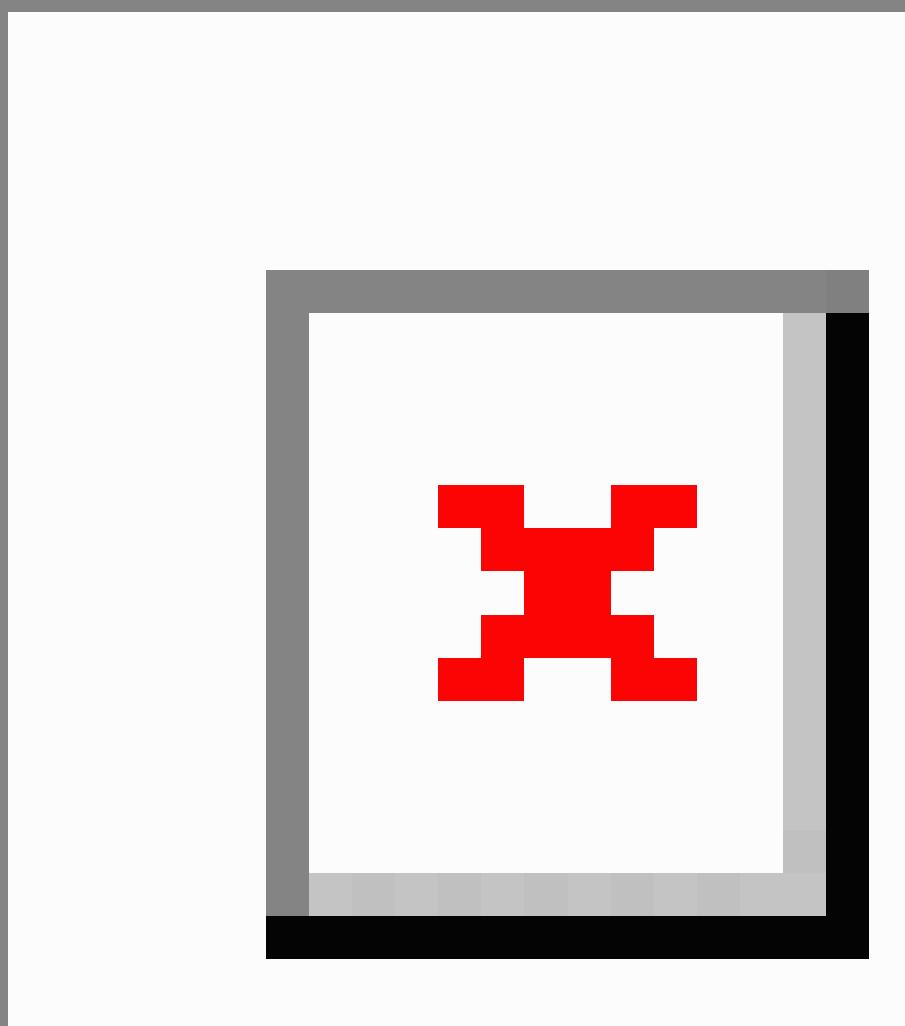
Figure 1. “Erietta” simulation: the treatment